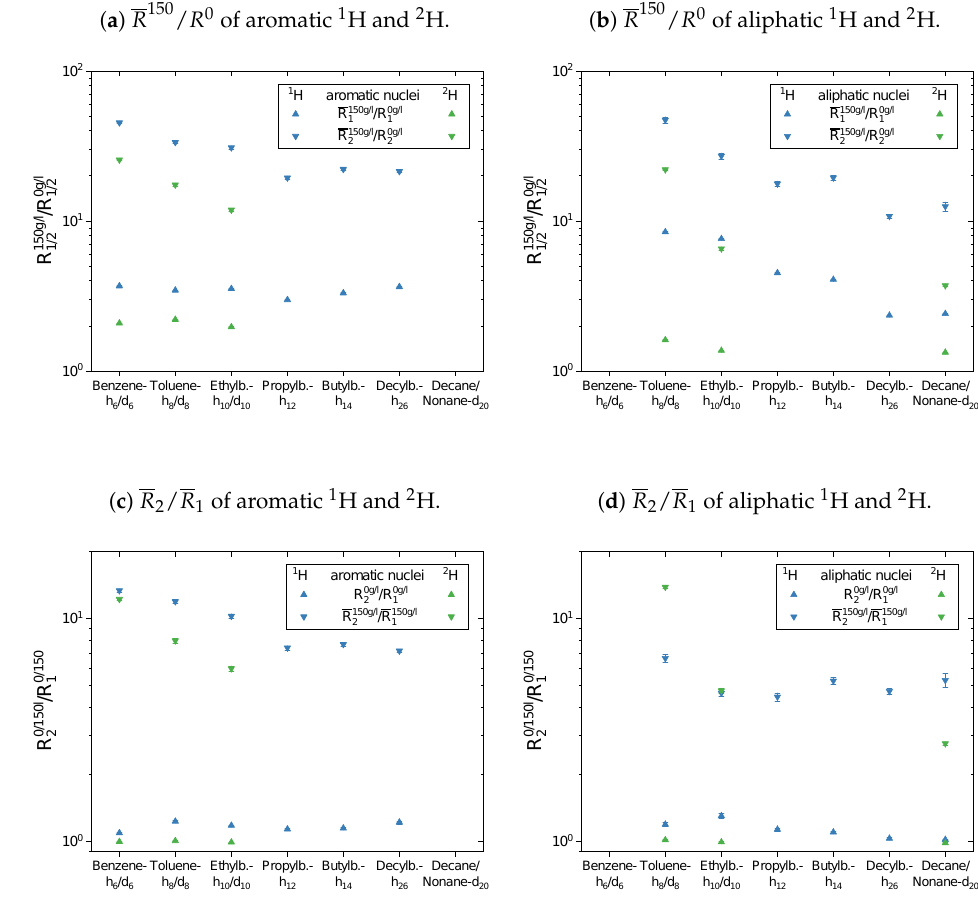
Figure 13. Top: Mean relaxation rates of the aromatic ( a ) and aliphatic ( b ) maltenes’ hydrogen isotopes in the presence of the asphaltene normalized to the corresponding relaxation rates in the asphaltene-free solution. Bottom: R 2 / R 1 ratio of the investigated aromatic ( c ) and aliphatic ( d ) maltenes’ nuclei in the asphaltenic and asphaltene-free